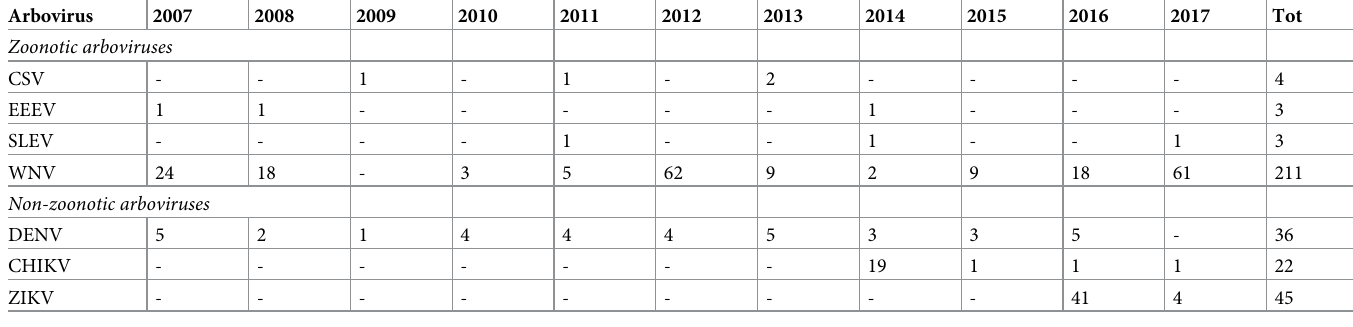
Table 1. Reported Arboviruses disease cases by disease agent from 2007 to 2017 in Alabama. California serogroup virus (CSV), Eastern equine encephalitis virus (EEEV), Saint Louis encephalitis virus (SLEV), West Nile virus (WNV), Dengue virus (DENV), Chikungunya virus (CHIKV), Zika virus (ZIKV) human cases were divided in two groups by competent mosquito vector genus ( Culex spp. and Aedes